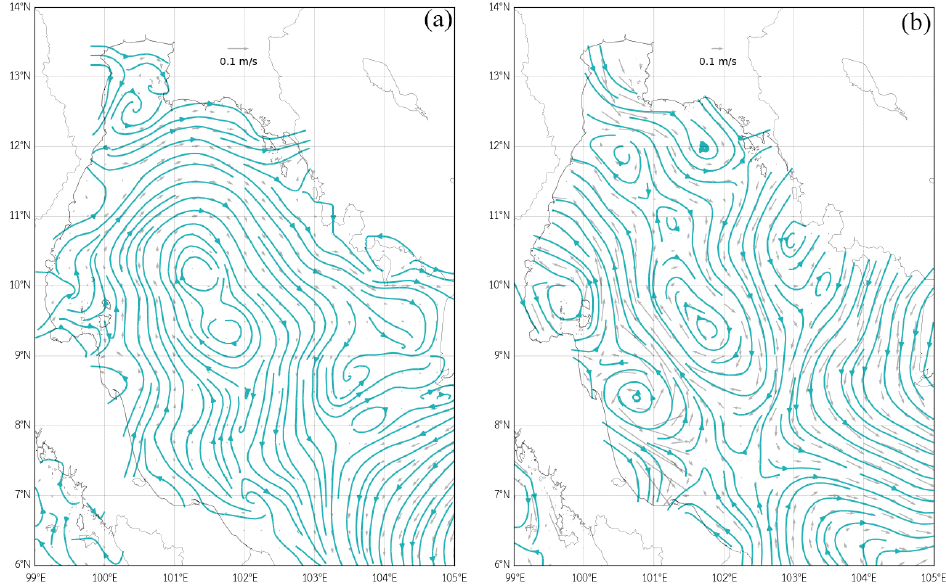
Figure 8. The simulated ( a ) mean surface current velocity from OCM and ( b ) mean surface current from OSCAR in July